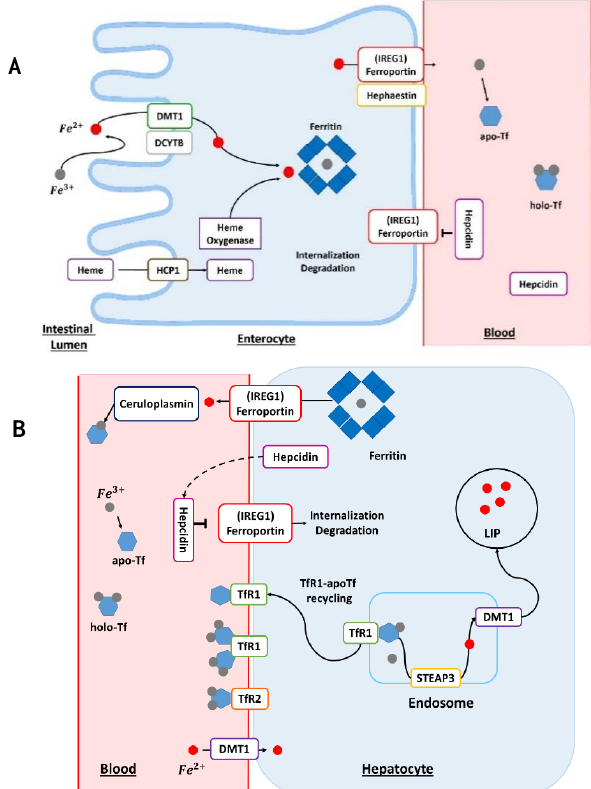
Figure 1. ( A ) : The enterocyte: absorption site of dietary heme and non-heme iron. The Fe in the diet is mainly in the form of ferric Fe (Fe 3 + ). Before its absorption into the enterocyte, Fe is reduced by the action of a reductase, such as duodenal cytochrome b (DCYTB). The ferrous Fe (Fe 2 + ) subsequently enters the cell via the divalent metal transporter 1 (DMT1). Heme Fe is absorbed by the action of the heme carrier protein 1 (HCP1). The heme is degraded by the action of heme oxygenase and then ferrous Fe is released. The Fe contained in the cell may be stored in ferritin-bound form or it may be delivered to the circulation by the action of ferroportin, also known as iron-regulated transporter 1 ( IREG1 ). Before joining the systemic circulation, the Fe is oxidized by hephaestin; then, Fe binds to transferrin (Tf), which can bind two ferric atoms (Fe 3 + ). apo-Tf, apotransferrin; holo-Tf, holotransferrin. ( B ) : The hepatocytes: principal storage site of iron. In blood, transferrin-bound Fe binds to transferrin receptor 1 (Tfr1) at the plasma membrane. The transferrin receptor 2 (Tfr2) protein